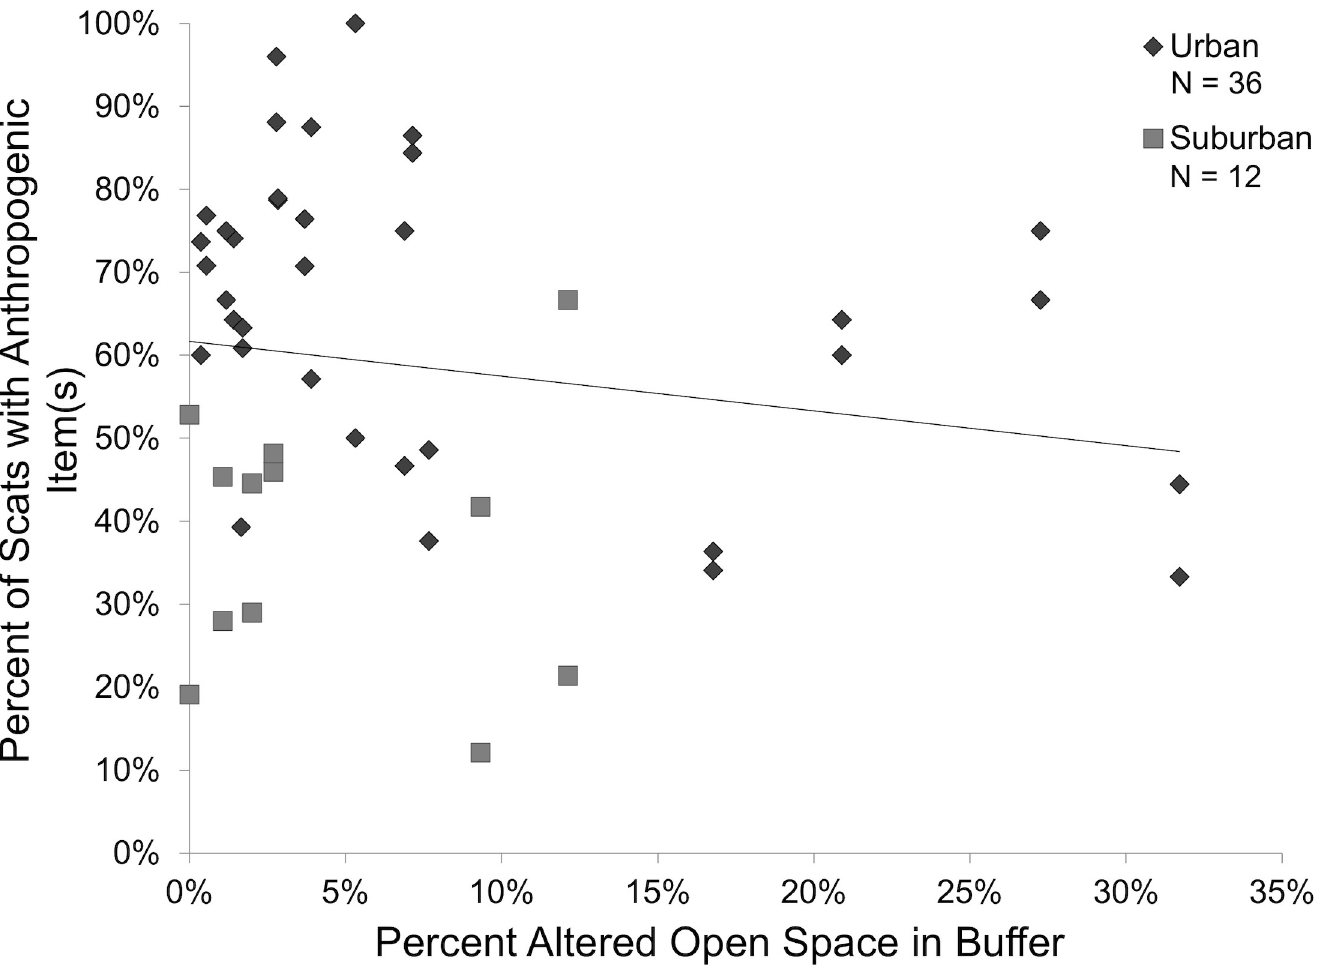
Fig 2. Land use effects on the occurrence of anthropogenic items in scat. The percent of the buffer zone around a scat line that is altered open space cover and the percent of scats collected from that line that had anthropogenic item(s). N refers to the total sample size for the study area (each scat transect has two data points: one for wet season frequency of occurrence and one for dry season frequency of occurrence). Solid black line represents a linear best-fit model.